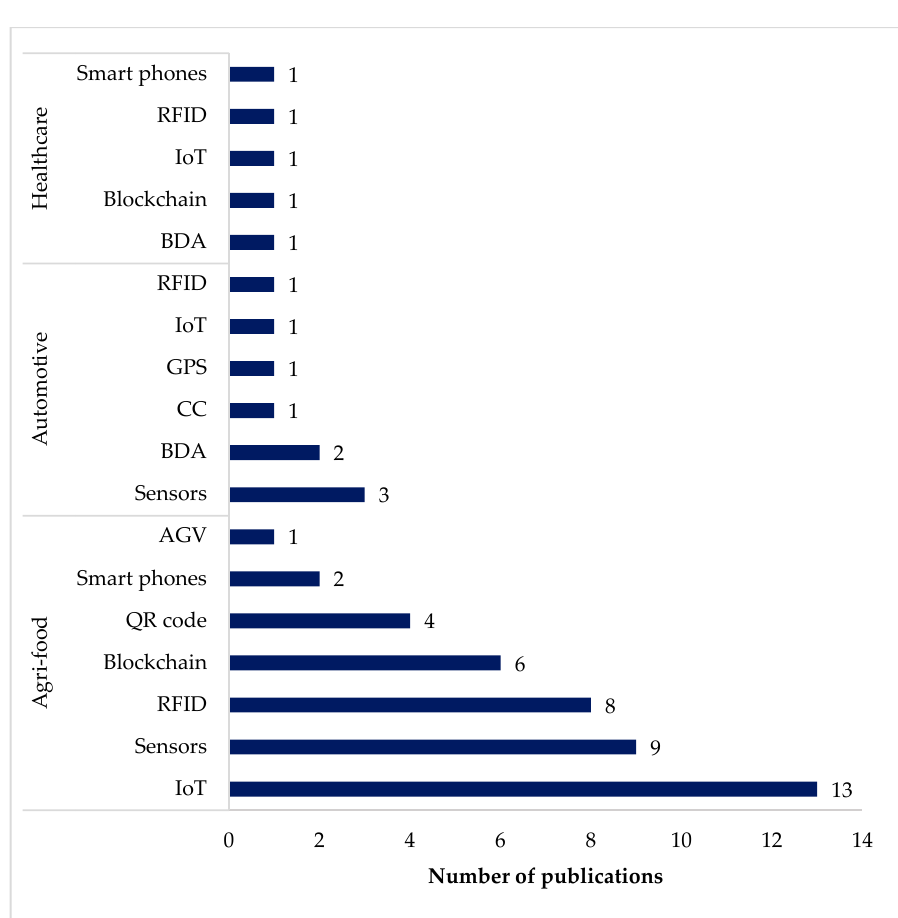
Figure 8. Distribution of the papers reviewed based on the sector(s) focused upon.